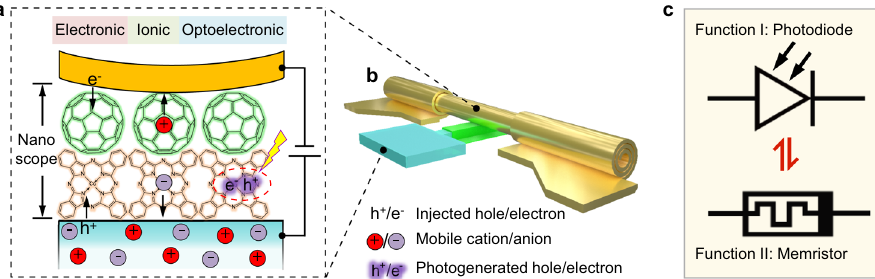
Fig. 1 Schematic showing the concept of functional molecular devices based on electronic-ionic synergistic effects. a Schematic illustration of electronic/ionic/electronic-ionic transport on the molecular scale under various external stimuli such as electrical and optical excitation. One electrode (e.g., the bottom electrode) also acts as a controllable “ ion reservoir ” to supply mobile ions. b The concept in a can be realized by integrated molecular devices based on damage-free rolled-up soft contacts. c Based on the con fi guration in b , a transition between photomultiplication and memristive switching is realized in the on-chip integrated devices by controlling the electronic-ionic transport in the molecule